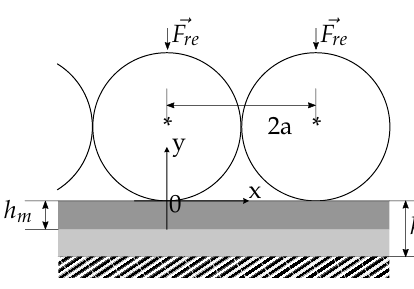
Figure 3. Sketch of the simplified two dimensional model of the rolling element problem for analytical